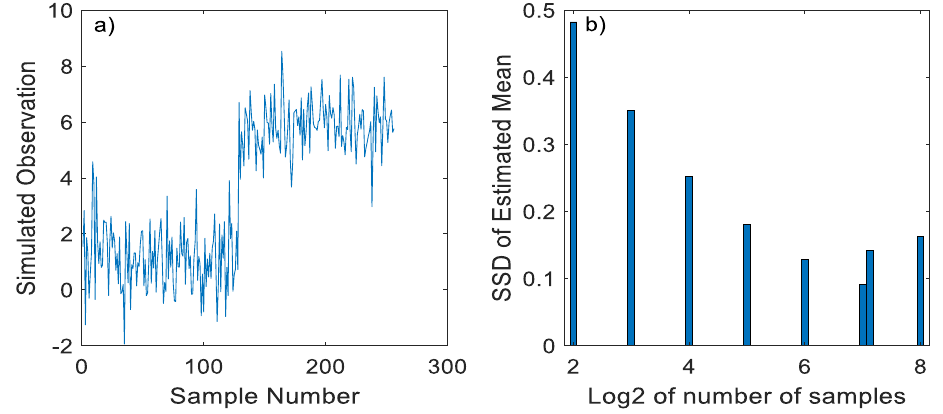
Figure 2. ( a ) Realization of simulated random process with 256 samples; the mean jumps from 1 to 6 at sample number 129. ( b ) Sample standard deviation (SSD) in estimating mean of a bin, or segment, as a function of log2 of the number of samples used (4, 8, 16, 32, 64, 128, 140, and 256). The SSD decreases until the segment becomes bigger than the region with constant mean (>128 points in this case), as illustrated by the SSD increase between sample sizes of 128 and 140 points. Log2 of these two sizes are 7.0 and 7.1, respectively, so their corresponding vertical bars are adjacent.